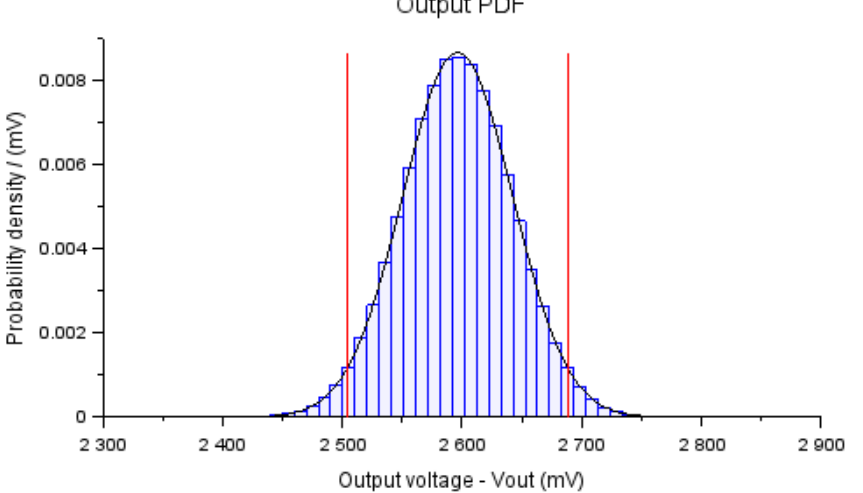
Figure 6. PDF for V out obtained using the MCM for the approximate model (3) using the information summarized in Table